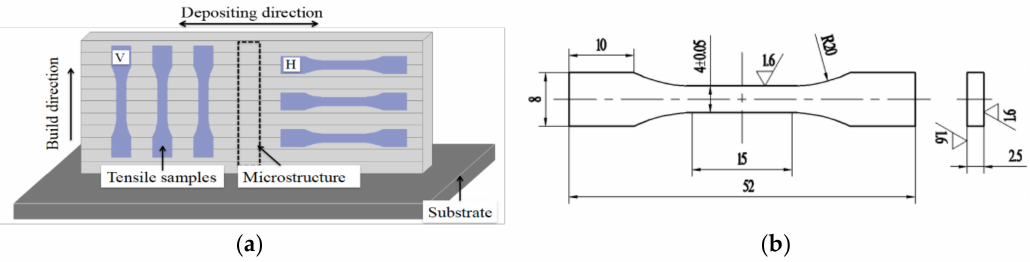
Figure 3. ( a ) Schematic graph of the sampling positions; ( b ) the dimensions (mm) of tensile